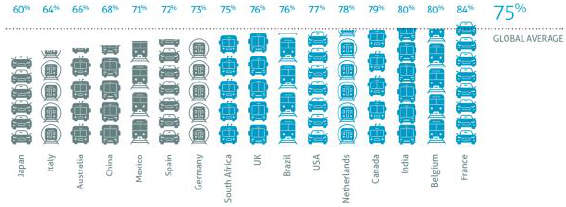
Fig 3. Flexible working used to shorten commute times (International Workplace Group, 2019).